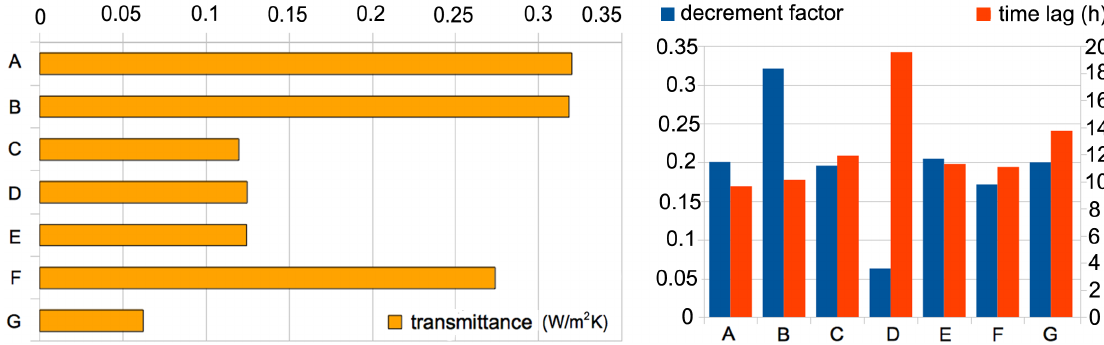
Figure 8. Energy analysis results. Left : thermal transmittance. Right : decrement factor and time